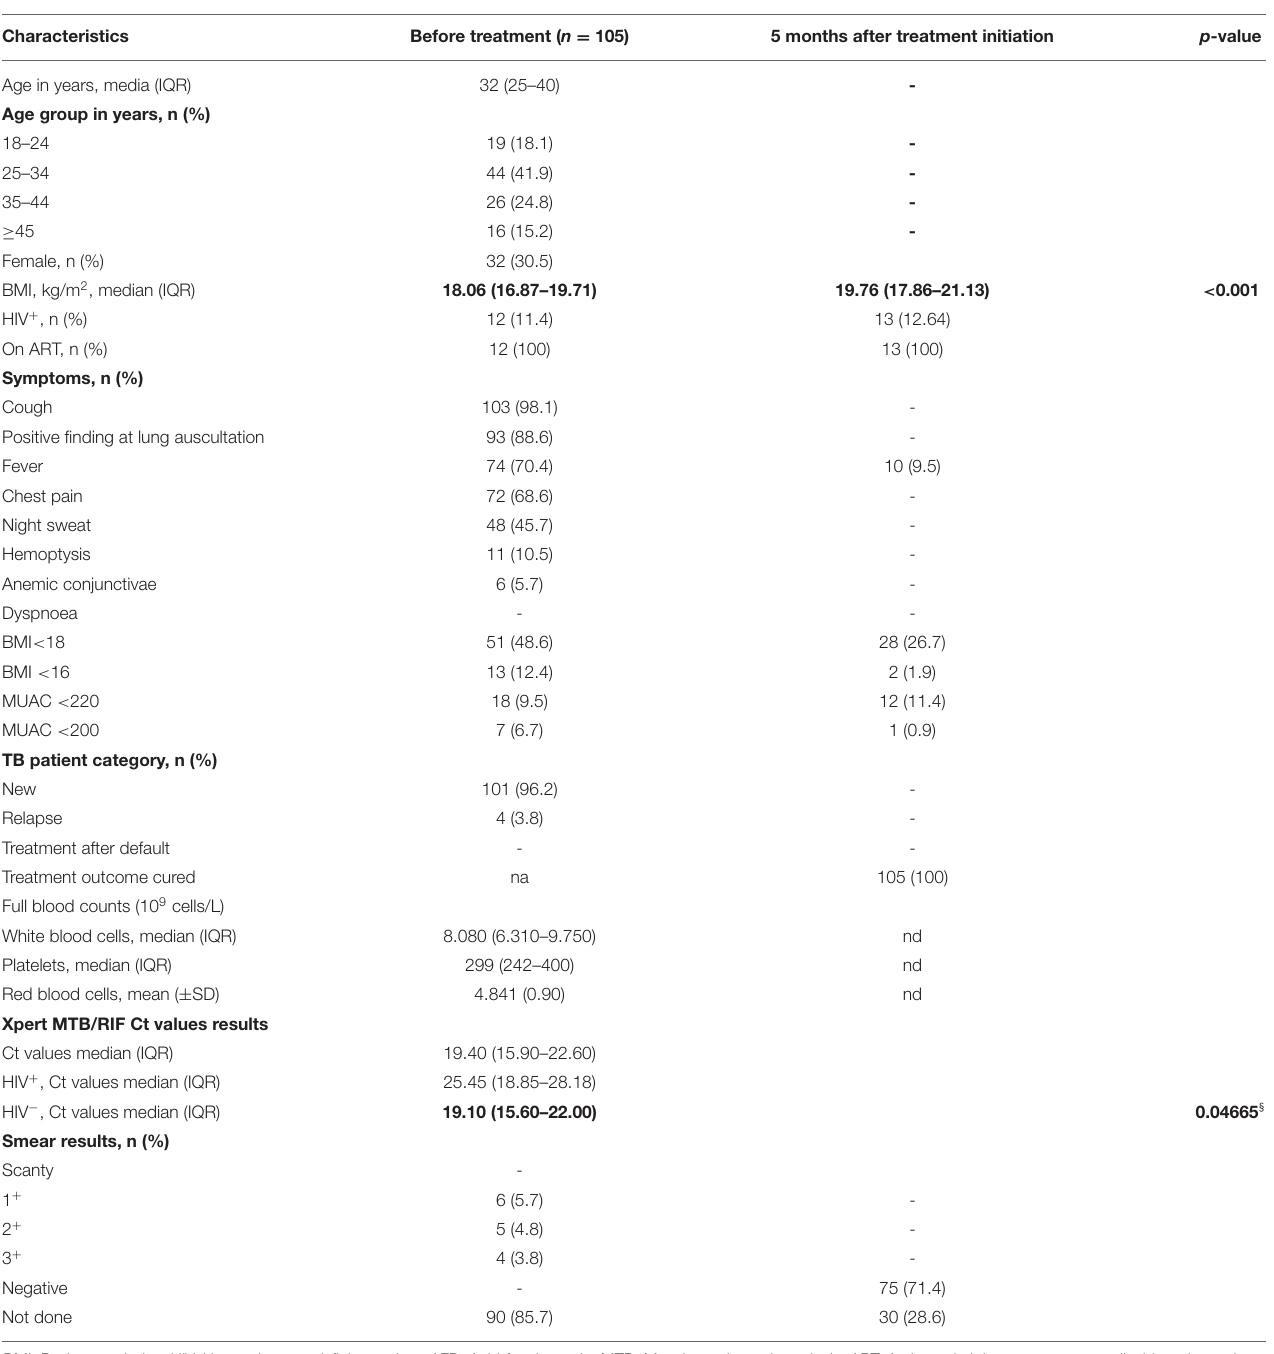
TABLE 1 | Demographics and clinical characteristics before and after 5 months of treatment.